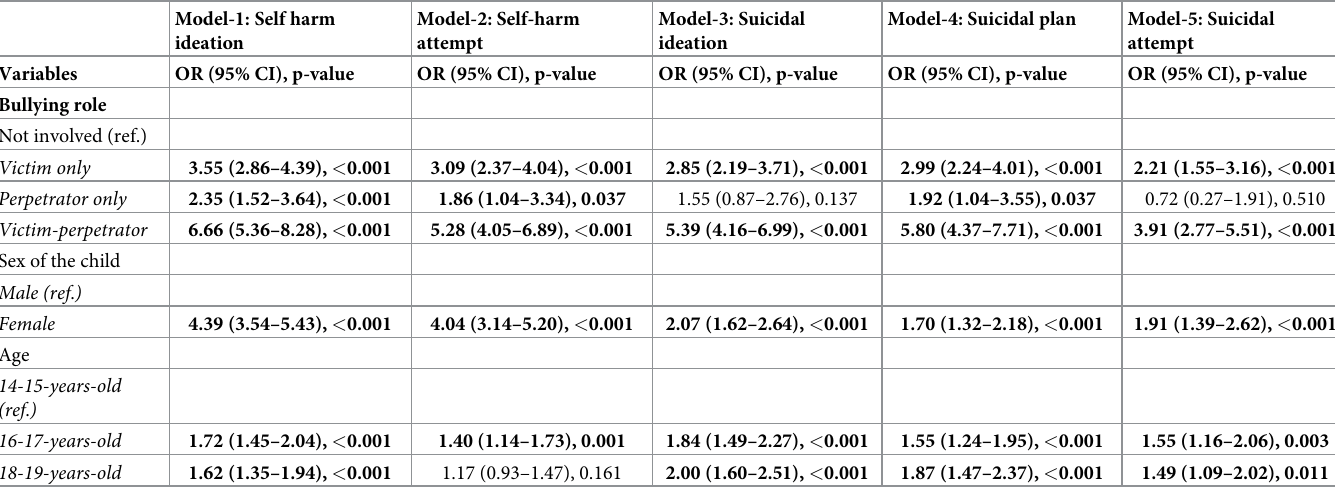
Table 3. Adjusted base models predicting self-harm and suicide-related